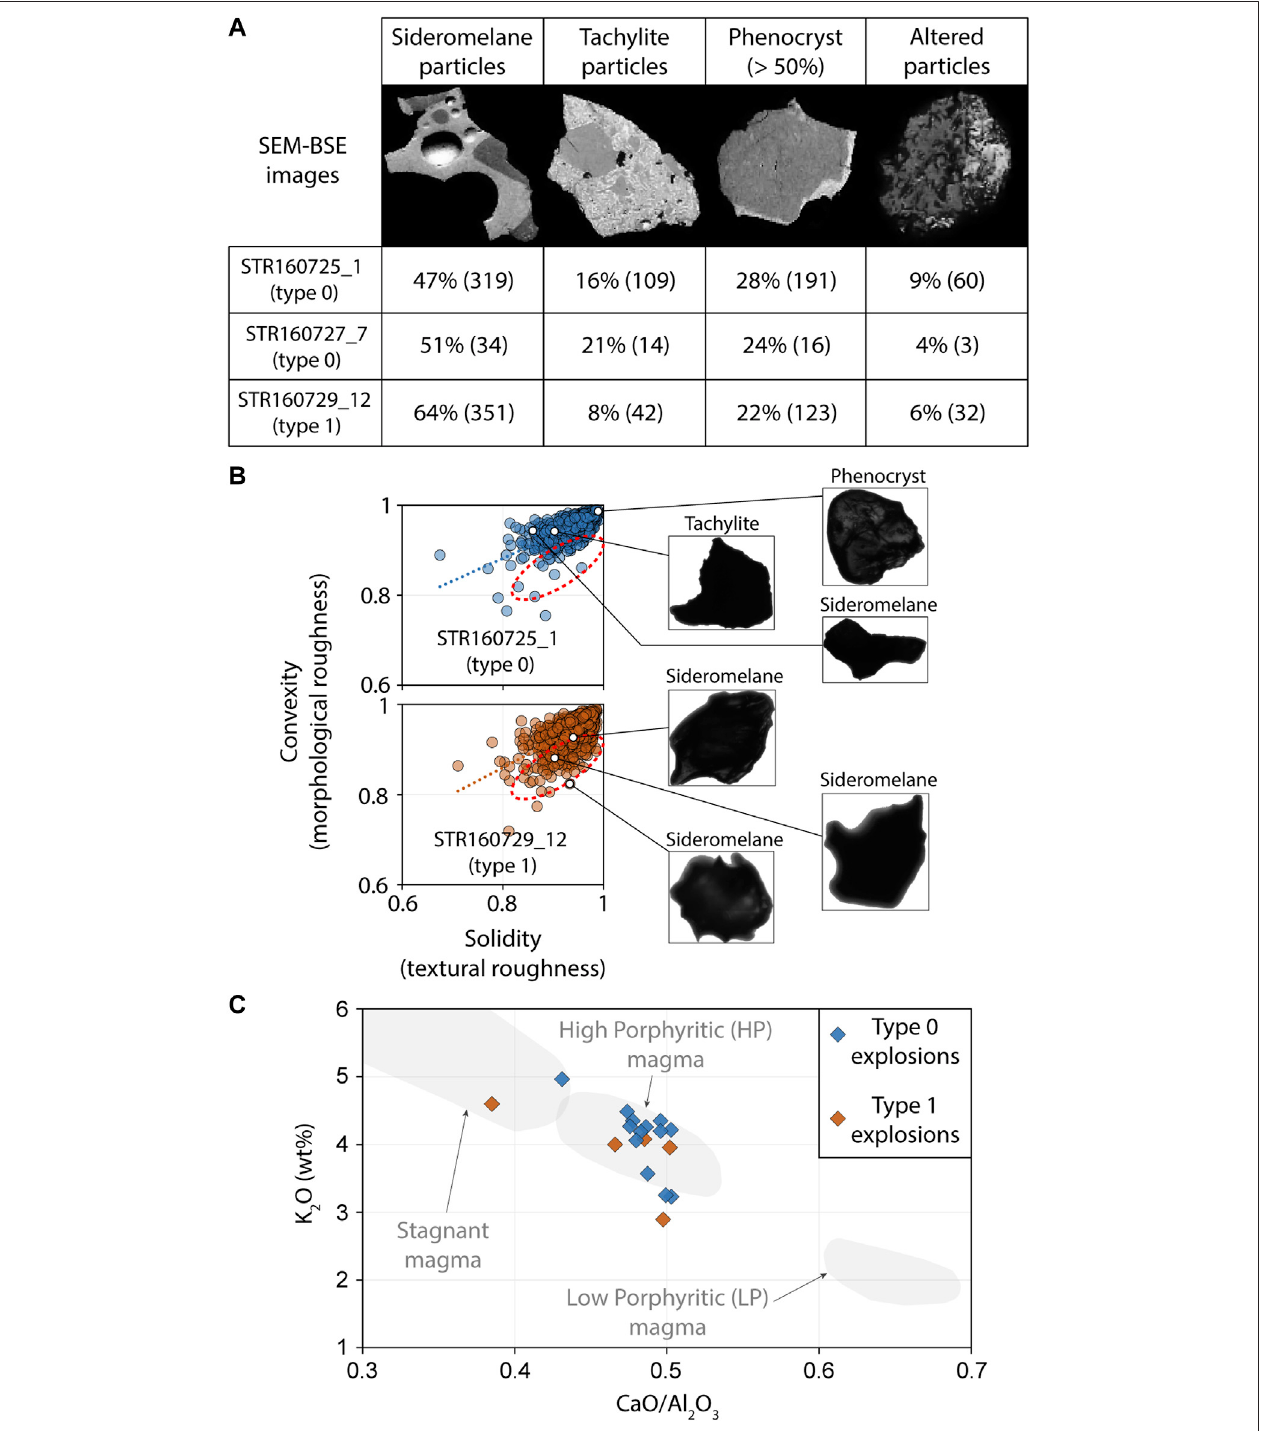
FIGURE 8 | (A) Componentry analysis of the three collected samples performed within the 180 – 250 µm grain size bin and using Back-Scattered Electron (BSE) images acquired with a Scanning Electronic Microscope (SEM). The percentage of each component is derived from the number of particles identi fi ed and counted manually(the numbers ofcounted particlearerepresented inparentheses). (B) ApparentProjectedshape ofASH (APASH)for theSTR160725_1(type 0explosion)and STR160729_12(type1explosions)samples,representedwithintheSolidityvs.Convexitygraphs.Lineartrendsarerepresentedbythedashedlines.Theredcircle show the same area in both graphs, evidencing the occurrence of another ash population for the STR160729_12 sample. (C) In-situ glass compositions of the sideromelane particles. The different composition fi elds were reconstructed from Metrich (2005), Gurioli et al. (2014), Pioli et al. (2014), Leduc et al. (2015) data.